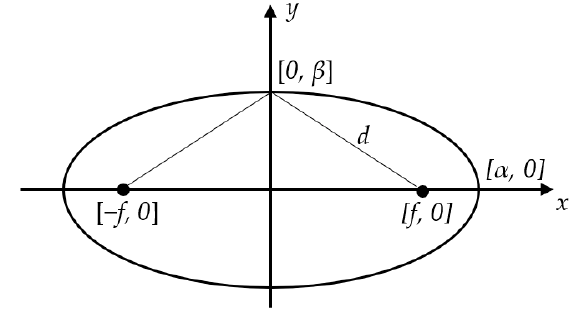
Figure A1. Ellipse Figure A1. Ellipse parametrization.